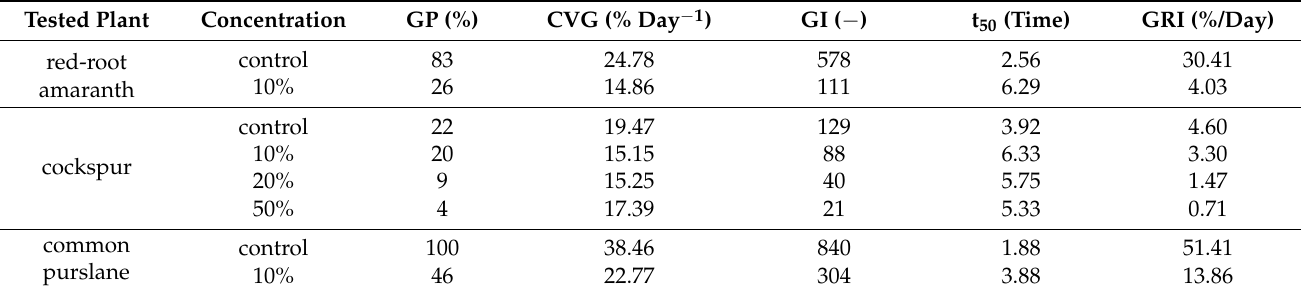
Table 2. The obtained results for the calculated germination indices in the case of the tested weed species treated with T . vulgaris hydrolate